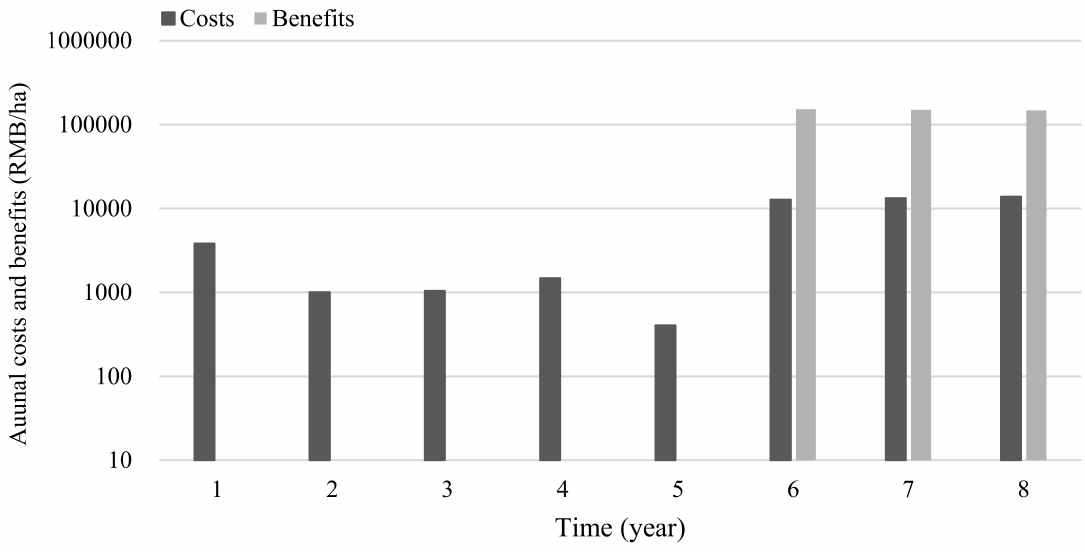
Figure 3. Annual costs and benefits of planting H. ammodendron .